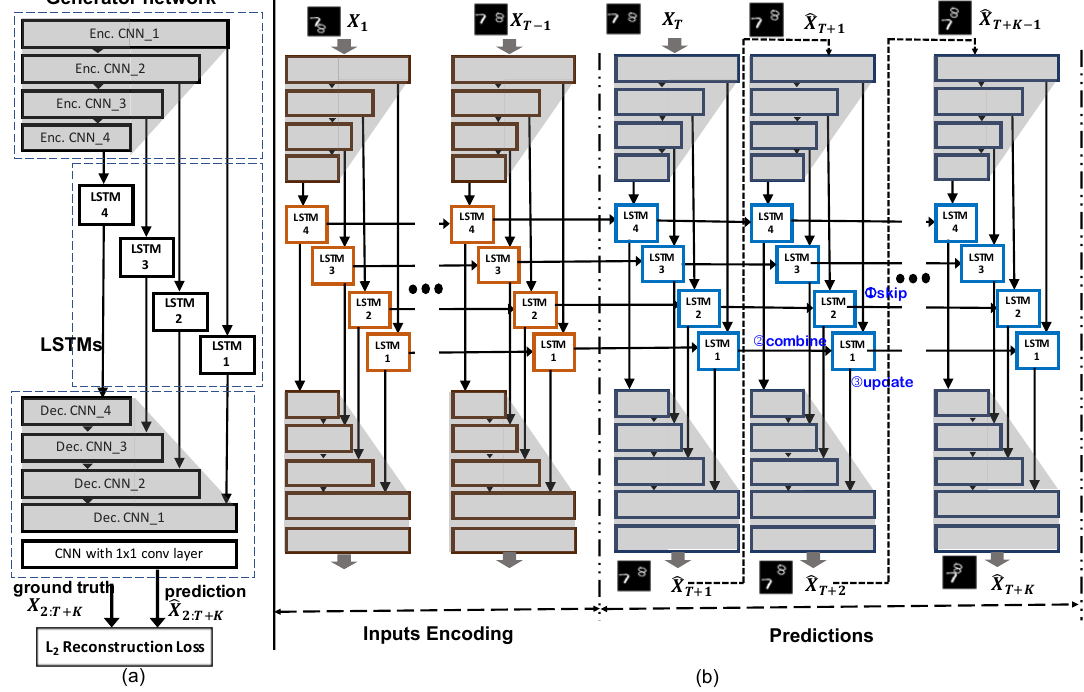
Figure 1. ( a ) Overview of the 4-level Hierarchical Recurrent Predictive Auto-Encoder (HRPAE) architecture. ( b ) Network unrolled over time